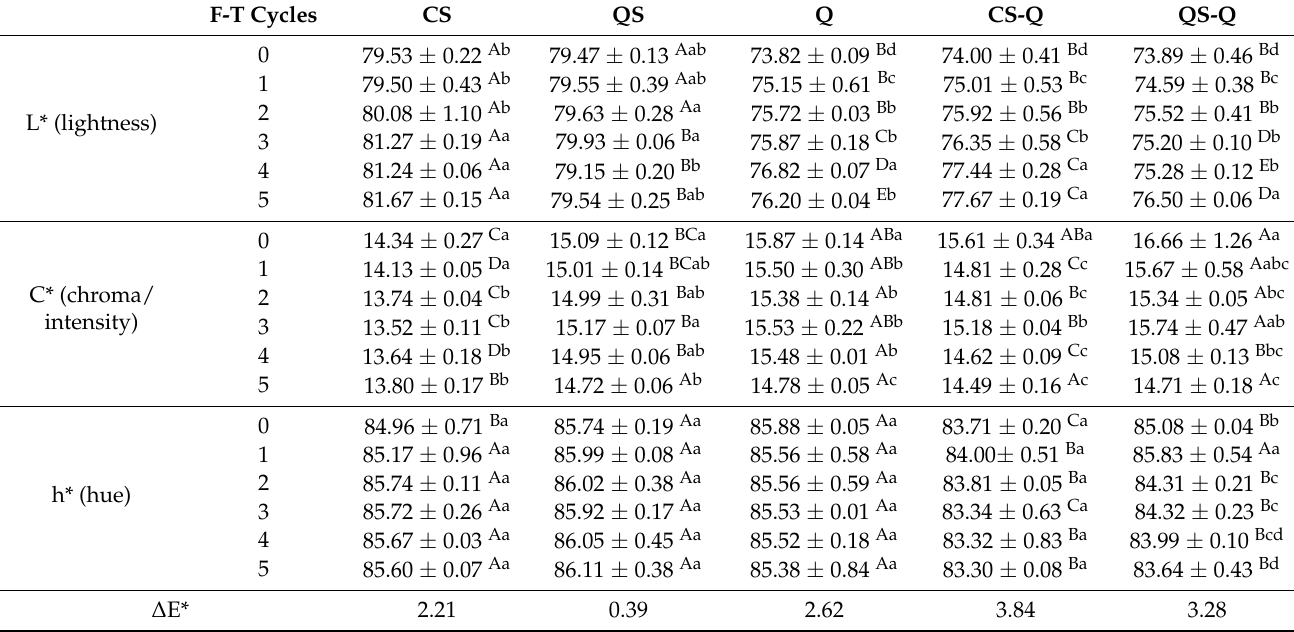
Table 4. Instrumental color (L*, a*, and b*) of chicken meatballs during five F-T